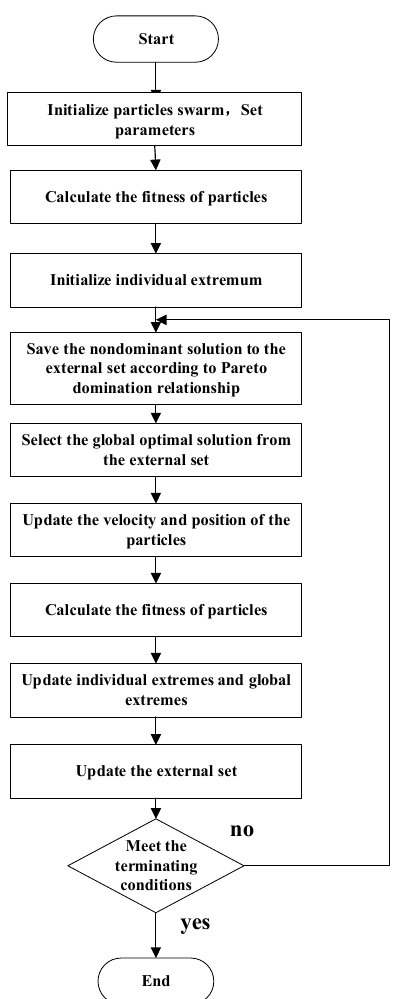
Figure 3. Flow chart of MOPSO.